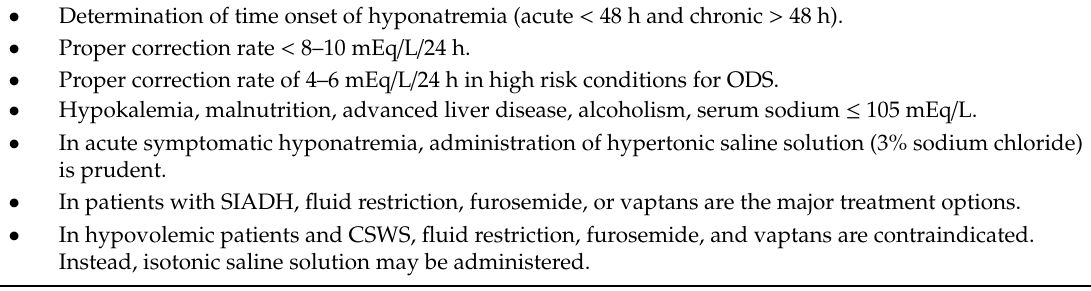
Table 3. Basic principles of hyponatremia